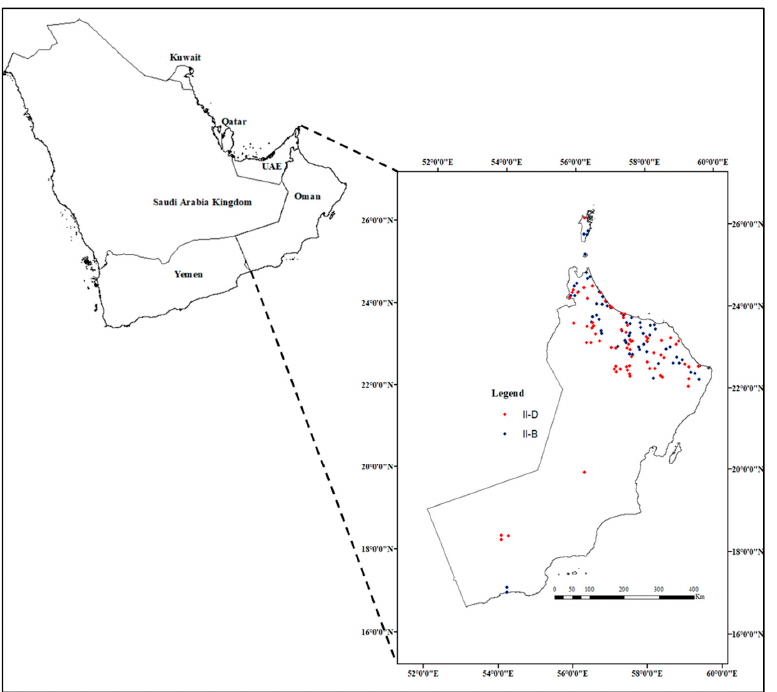
Figure 1. Occurrence data distribution for 16SrII-B (lime, blue color) and 16SrII-D (alfalfa, red color).